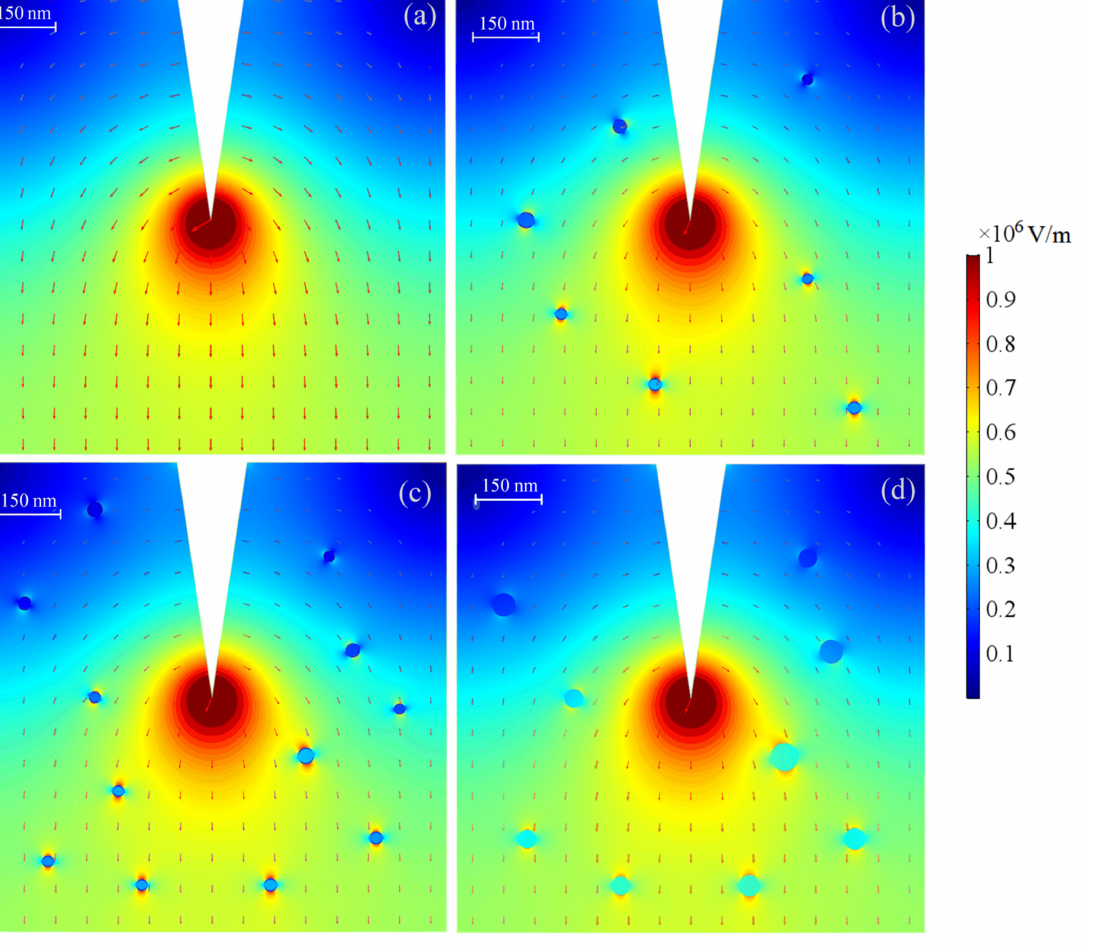
Figure 7. Electric field distributions around initiation tip (identical to tree front) simulated for ( a ) XLPE, ( b ) 0.5 wt%TMPTA- s -SiO 2 /XLPE, ( c ) 1.5 wt%TMPTA- s -SiO 2 /XLPE, and ( d ) 1.5 wt%SiO 2 /XLPE